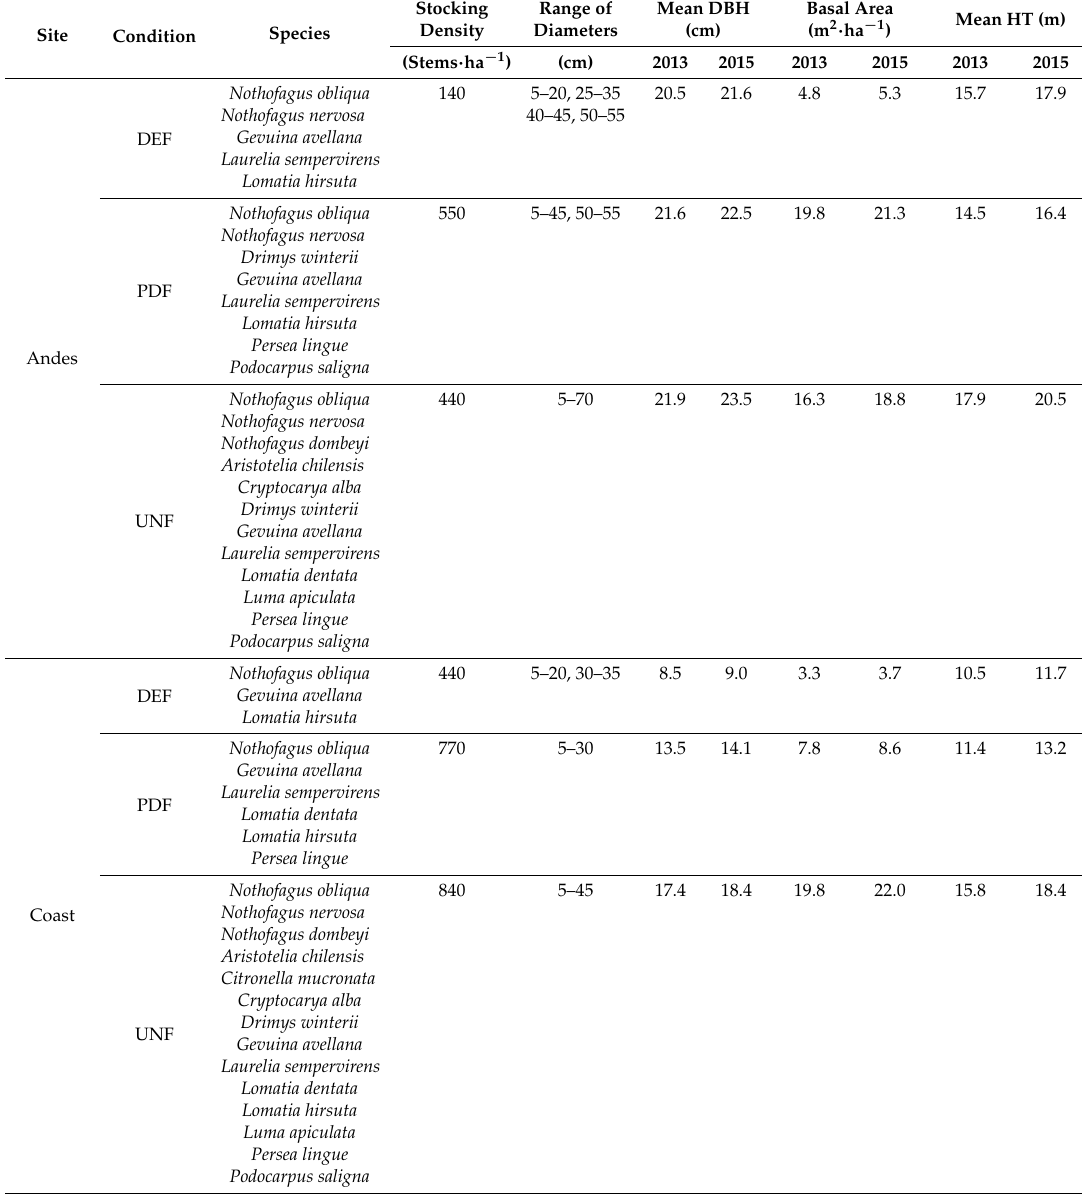
Table 1. Baseline information about the two study sites in the Andean and Coastal mountains of south central Chile: Condition (DEF: Degraded, PDF: partly-degraded, UNF: undisturbed forests), principal and accompanying species, and stand density (stems · ha − 1 ), range of diameters (cm), mean diameter at breast height-DBH (cm), basal area (m 2 · ha − 1 ), and mean total height-HT (m) of Nothofagus obliqua